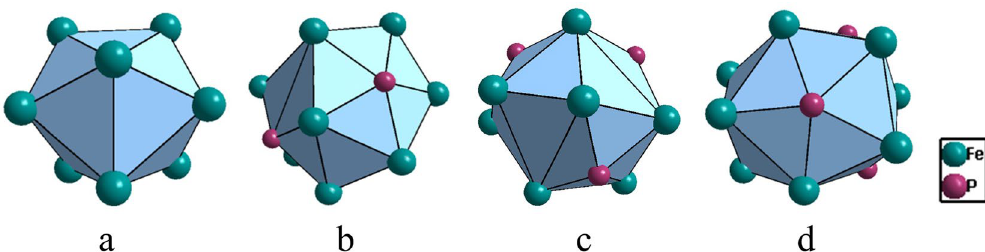
Figure 4. Clusters in Fe 3 P: capped trigonal prism [P-Fe 9 ] ( a ), CN14 [Fe-P 2 Fe 12 ] ( b ), CN13 [Fe-P 3 Fe 10 ] ( c ), and CN14 [Fe-P 4 Fe 10 ] ( d